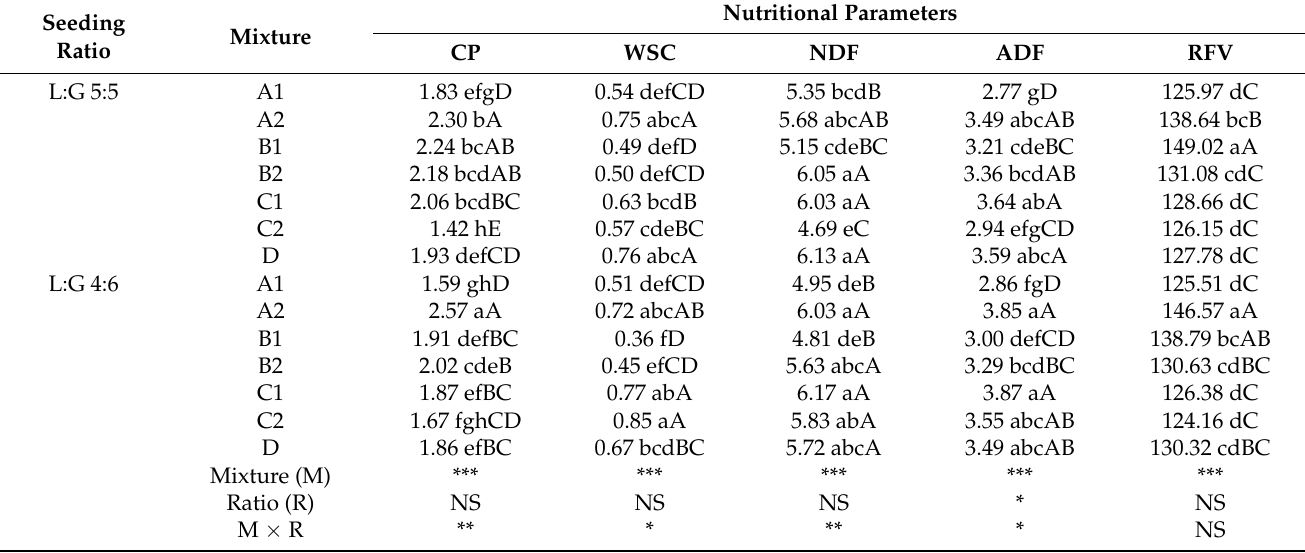
Table 5. Nutritional quality of legume–grass mixtures in two legume-grass seeding ratios in